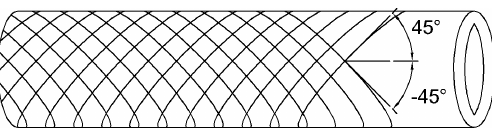
Figure 4. Angle-ply laminates.